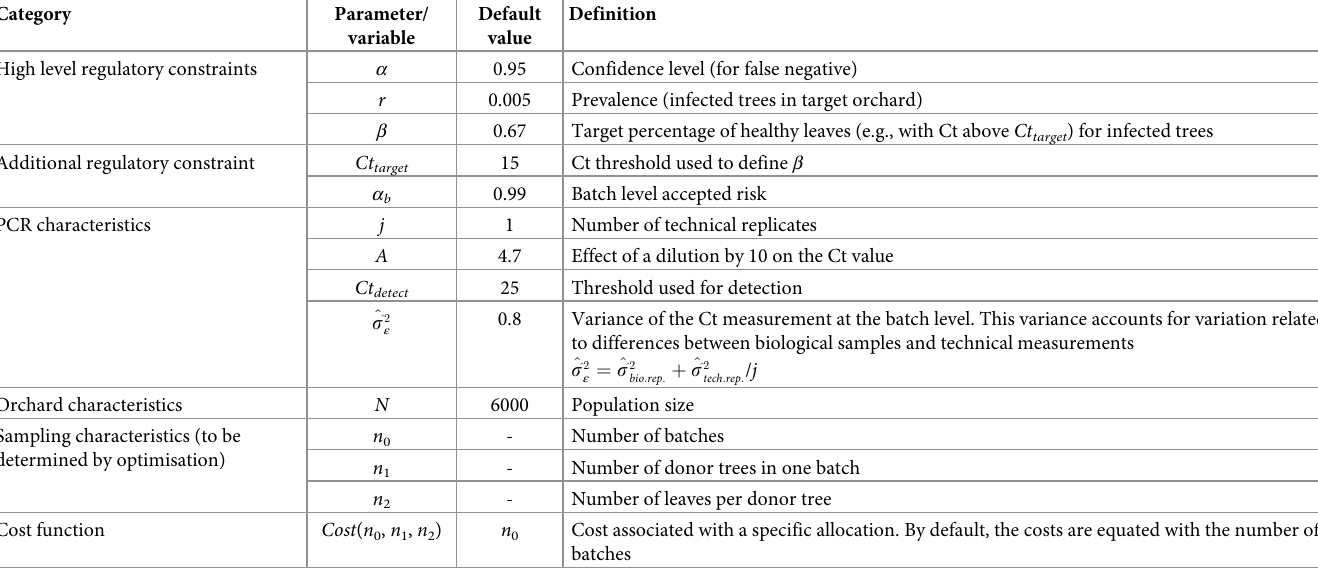
Table 1. Index of notation for parameter values, with default values, and variables used in computing an optimal sampling design for disease-free